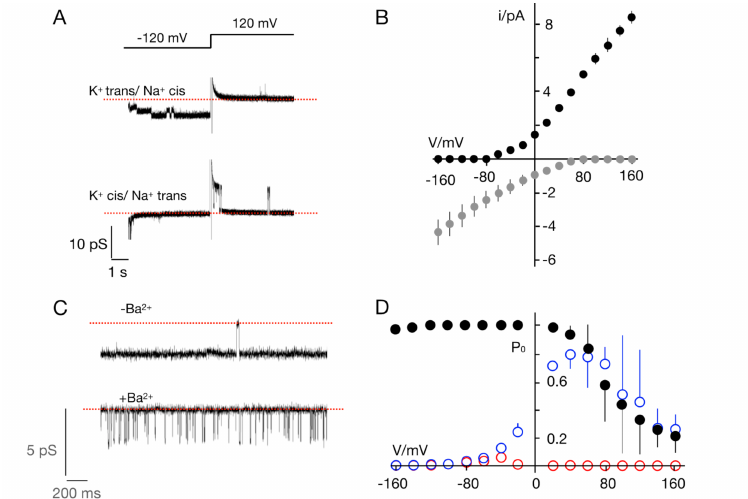
Figure 6. Ktv1 is K + selective and blocked by Ba 2 + . ( A ) Current recordings of Ktv1 at − 120 and + 120 mV. Channel activity was measured with 100 mM KCl in trans and 100 mM NaCl in cis chamber (top) and in the inverse orientation (bottom). The dashed red line shows zero current level. Open channel currents are only recorded in the direction of the K + fluxes. ( B ) Mean unitary channel current / voltage (I / V) relations for recordings with K + / Na + on cis / trans (black symbols) or on trans / cis (grey symbols). ( C ) Channel fluctuations at − 80 mV in symmetrical 100 mM KCl in the absence ( − Ba 2 + ) and presence ( + Ba 2 + ) of 5 mM BaCl 2 in the trans chamber. The dashed red lines mark the closed state of the channel. ( D ) Probability / voltage (P 0 / V) plot from control measurements in symmetrical 100 mM KCl (black symbols, same as 5C) and after adding 5 mM BaCl 2 to trans chamber (blue symbols) and to both chambers (red symbols). Data in B and C are means ( ± S.D.) of 3 independent